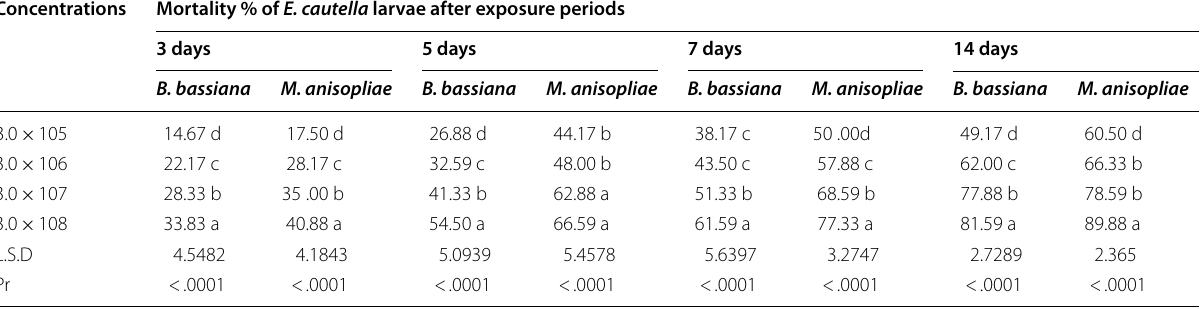
Mean in same column followed by the same letters is not significant L.S.D., least significant difference; Pr., probability level